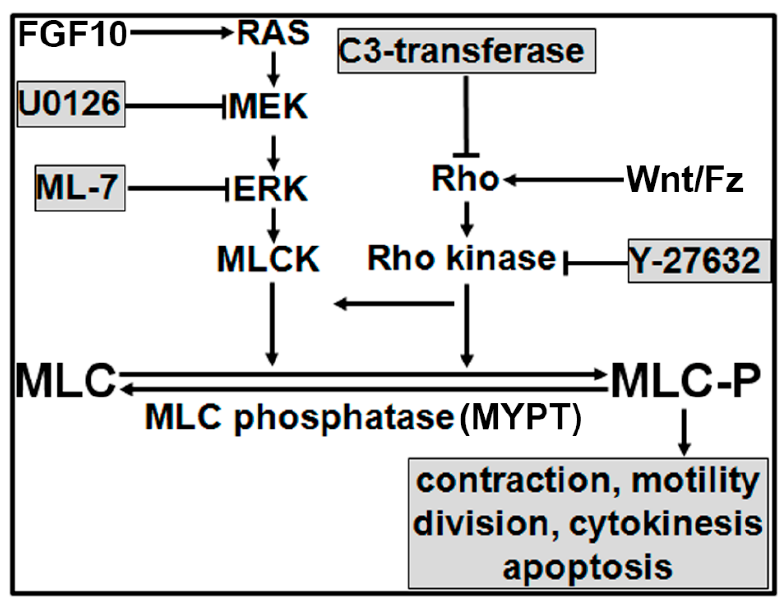
Figure 8. Working model. MLC-P plays a central role in cell proliferation, division, and migration, and MLCK is a dedicated kinase for MLC phosphorylation. Ras activation by FGF10 increases MLCK activity through MEK-activated ERK that phosphorylates MLCK. Rho, in contrast, increases MLC-P by phosphorylating and inactivating the targeting subunit of MYPT, which dephosphorylates MLC-P.